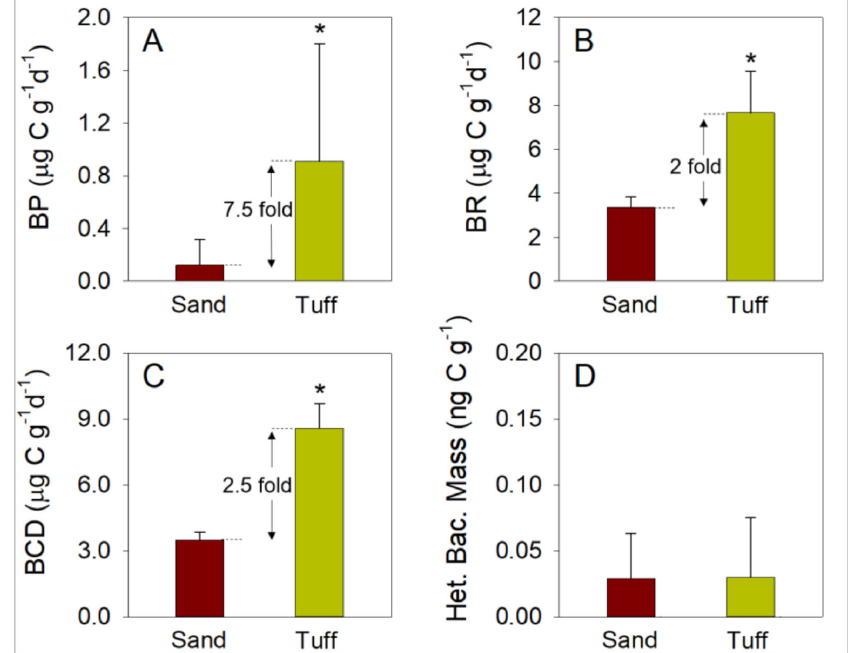
Figure 3. Average values of ( A ) bacterial production (BP), ( B ) bacterial respiration (BR), ( C ) bacterial carbon demand (BCD), and ( D ) the mass of total bacteria, which were measured from three independent column experiments conducted in May, August, and November 2018. Asterisks indicate a statistically significant di ff erence between measurements from the sand and the maturated tu ff ( p < 0.01, n = 12). It is surmised that the large standard deviations were due to the large di ff erences in values per experiment due to seasonal